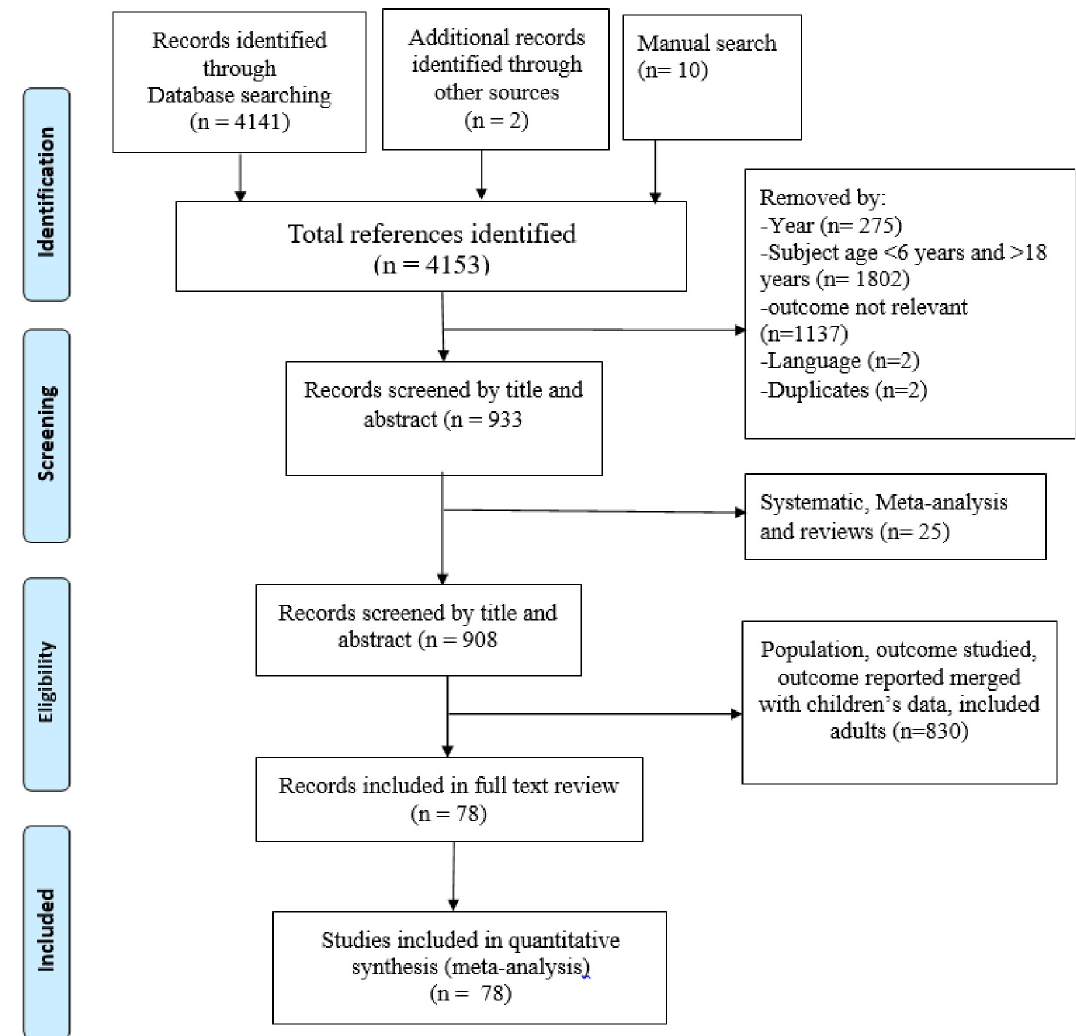
Fig 1. Flow chart for search and selection process of articles on adolescent nutrition and health in